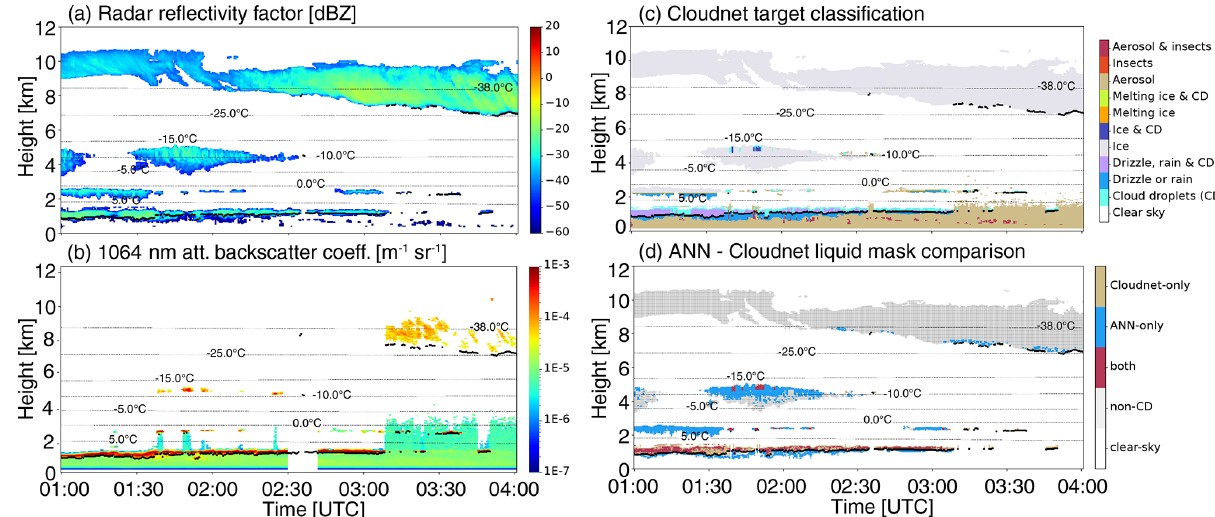
Figure 5. Observations and retrievals on 5 October 2014, 01:00–04:00UTC: (a) MIRA-35 radar reflectivity factor, (b) PollyXT 1064nm attenuated backscatter coefficient, (c) Cloudnet target classification, and (d) comparison of Cloudnet and ANN liquid masks. The first ceilometer cloud base is indicated by black dots.